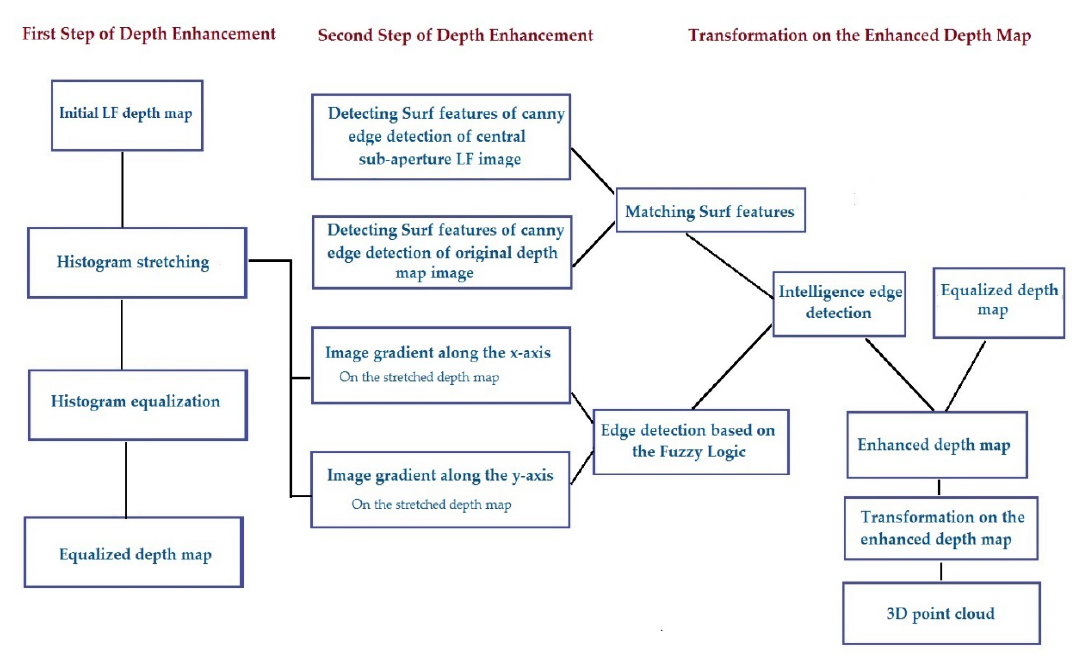
Figure 2. A block diagram of our approach.